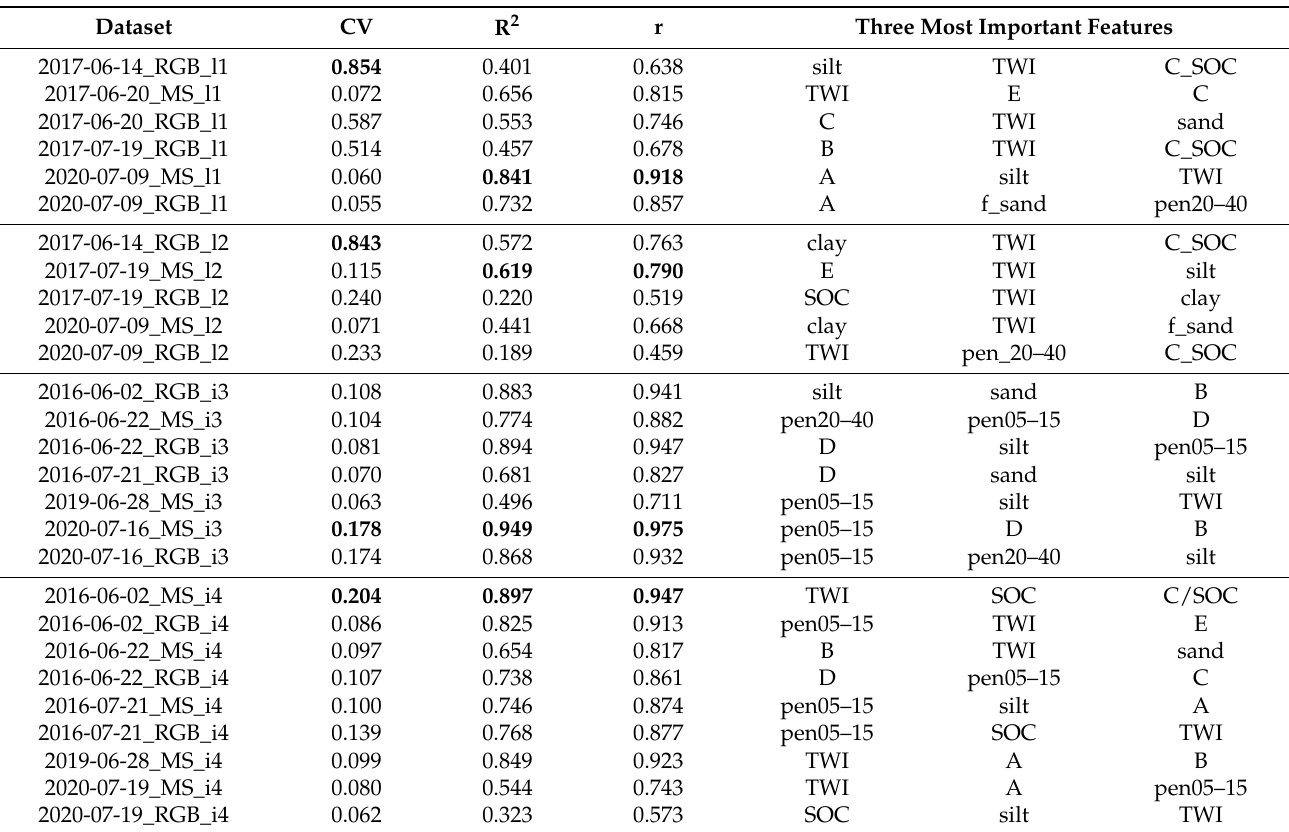
Table 4. Coefficient of variation (CV), R 2 , and r values of random forest models (the highest values of each field is bolded) and the three most important features affecting the model (datasets for RGB or multispectral (MS) cameras in fields l1, l2, i3, and i4). Acronyms of soil indicators as in Table